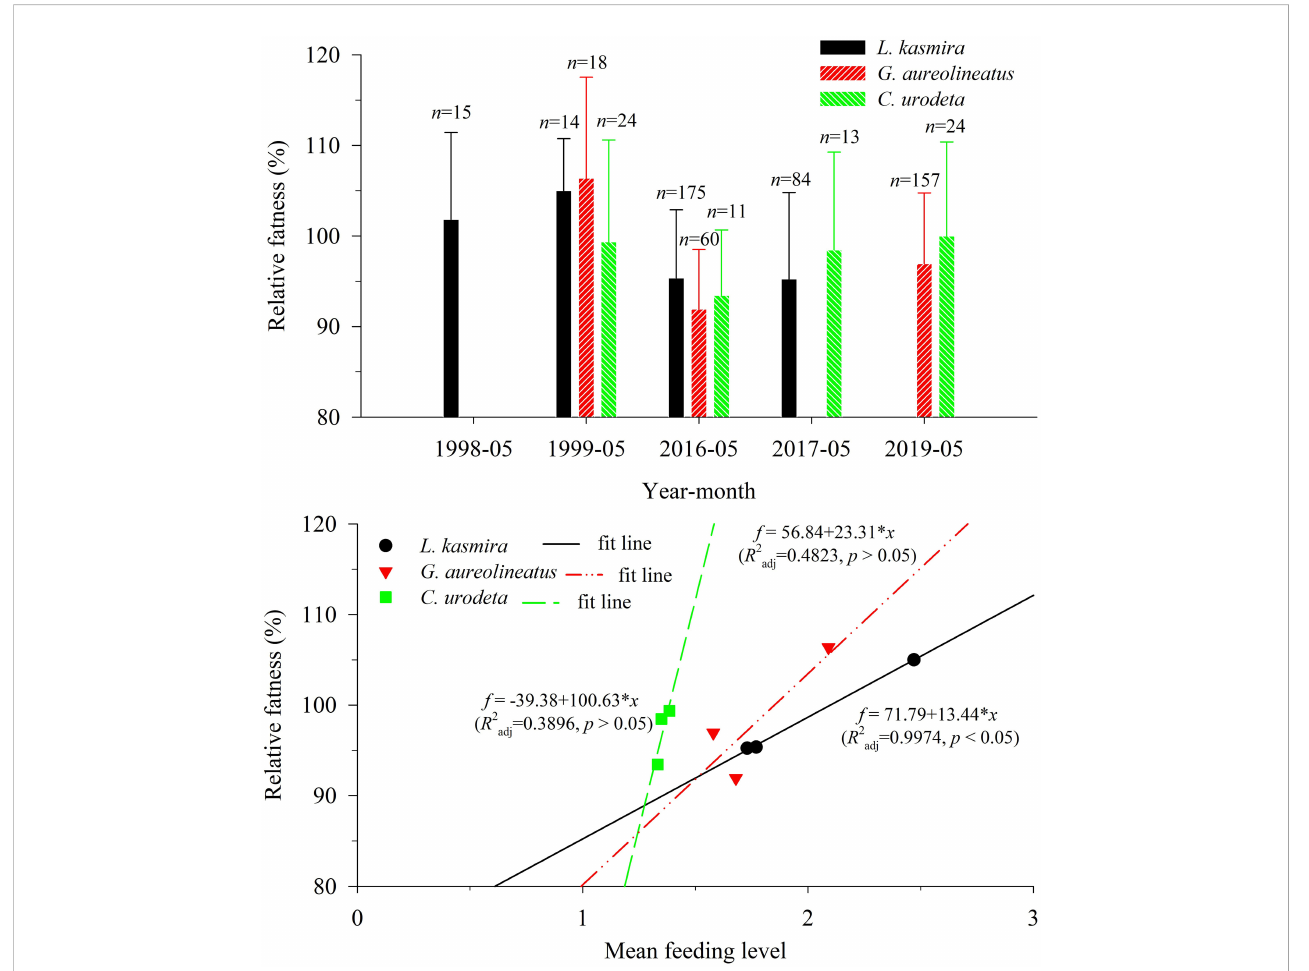
FIGURE 4 Variation in the relative fatness of Lutjanus kasmira , Gnathodentex aureolineatus and Cephalopholis urodeta in the Yongshu Reef, South China Sea and trend of relative fatness with mean feeding level. The error bar represents the corresponding standard deviation. The n above the error bar represents the number of corresponding replicate